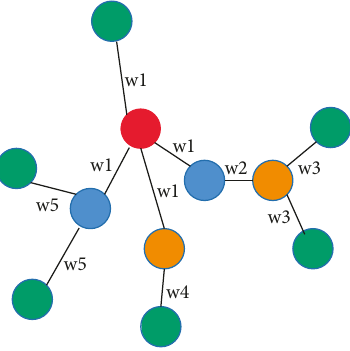
Figure 1: The typical architecture of NODEs. Feature extractor provides the initial state h methods.